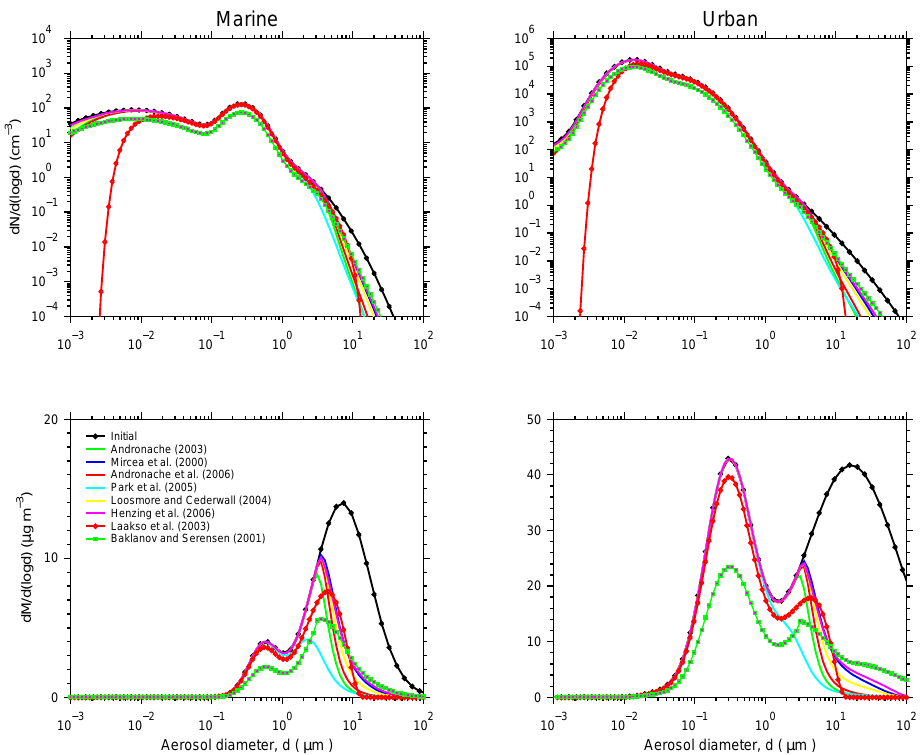
Fig. 10. Predicted size-resolved number (upper row) and mass (lower row) concentrations using six theoretical and two empirical 3 param- eterizations for typical marine and urban aerosol populations after two hours of rain with a rainfall intensity of 1mmh − 1 . Note that different y-axis scales have been used. Table 4. Percentage removal for three particle sizes (0.01, 0.1 and 1µm) predicted based on three 3 parameterizations after 5mm of rain for